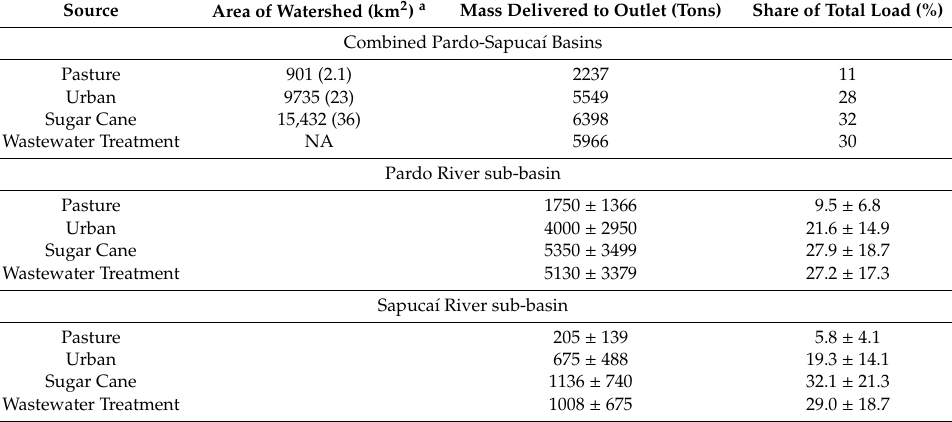
a Percent of total watershed area in